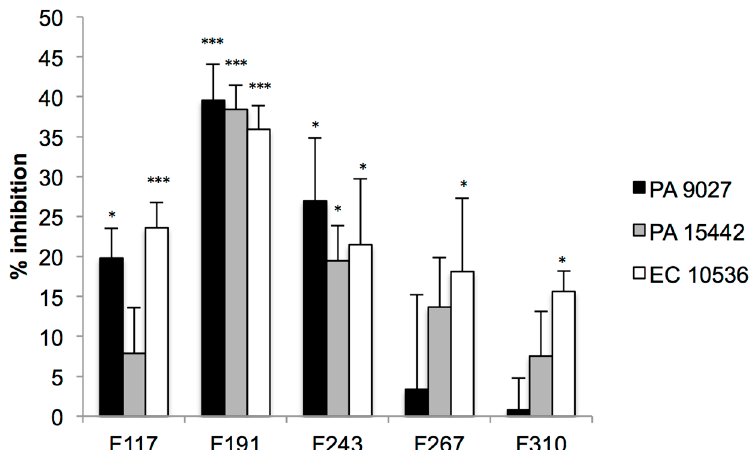
Figure 4. Activity of the QS inhibitors (leads, tested at 100 µ M) on the transition between microcolonies and fully-formed biofilms of E. coli and P. aeruginosa strains (indicated as EC or PA strains in the legend). The figure contains results of crystal violet staining, shown as percent of inhibition when compared to untreated control samples. Error bars represent SEM ( n = 6). *** p < 0.0001, * p < 0.05.